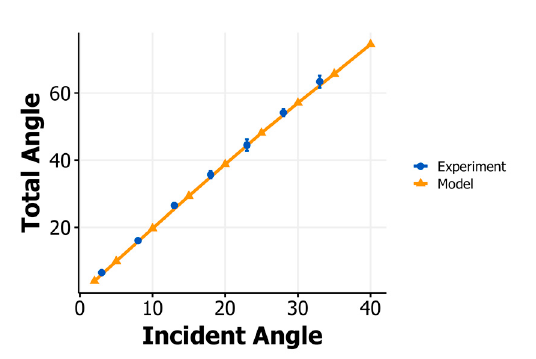
Figure 3. Total angle (incident angle plus outbound angle) vs. incident angle for experiment and model.